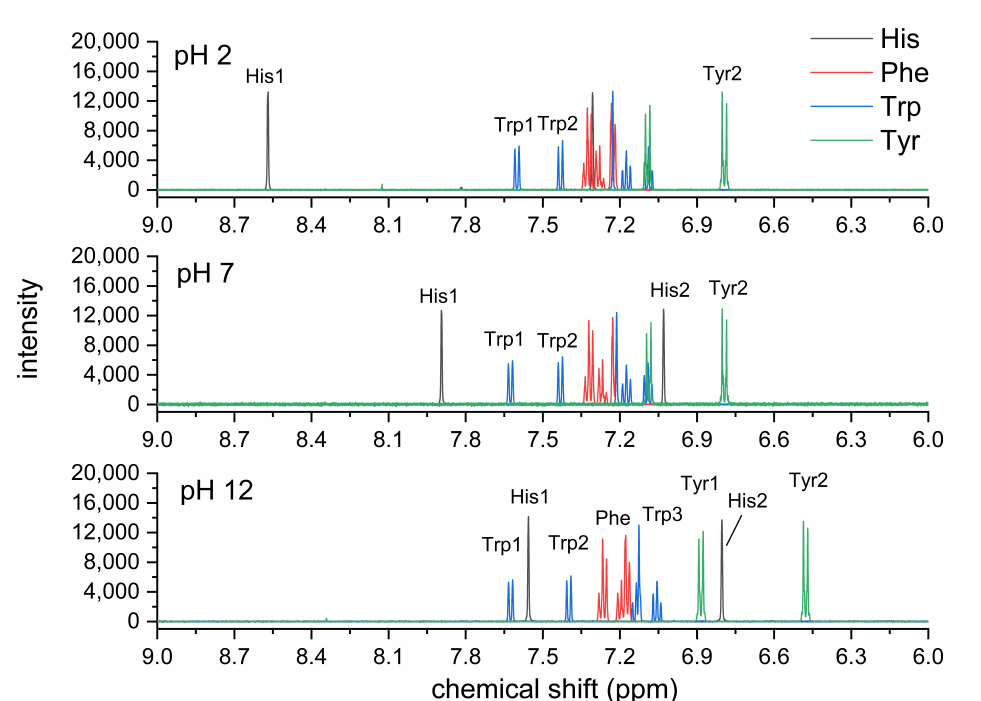
Figure 2. The pH-dependent signal shift in the aromatic region at pH 2, 7, and 12. Approximately. 1 mg/mL of each amino acid in deuterated 100 mM phosphate buffer 500 MHz spectrometer fre- quency, 16 scans, 5 s relaxation delay, 30° observation pulse, and no apodization. Signals observed in the pH 2 spectrum at ~ 7.8, and ~ 8.1 ppm may have been caused by non-identified impurities.